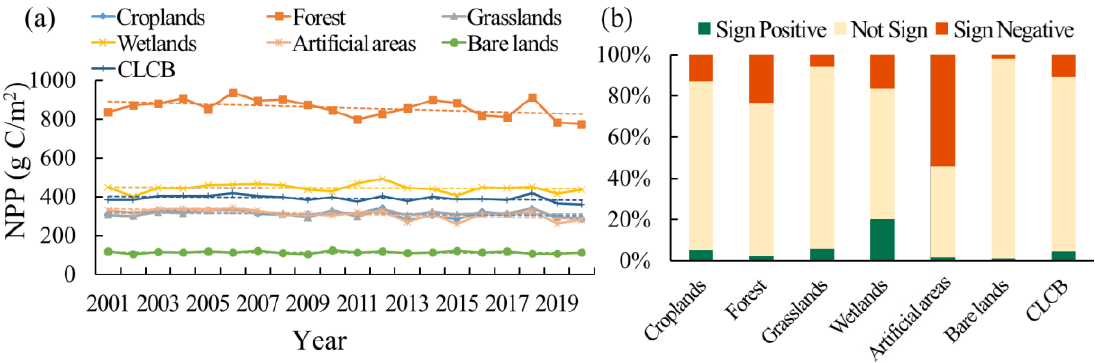
Figure 5. Interannual average NPP in each terrestrial ecosystem from 2001 to 2020. ( a ) Interannual variation trend of average NPP in the CLCB; ( b ) NPP variation proportion in each terrestrial ecosystem.